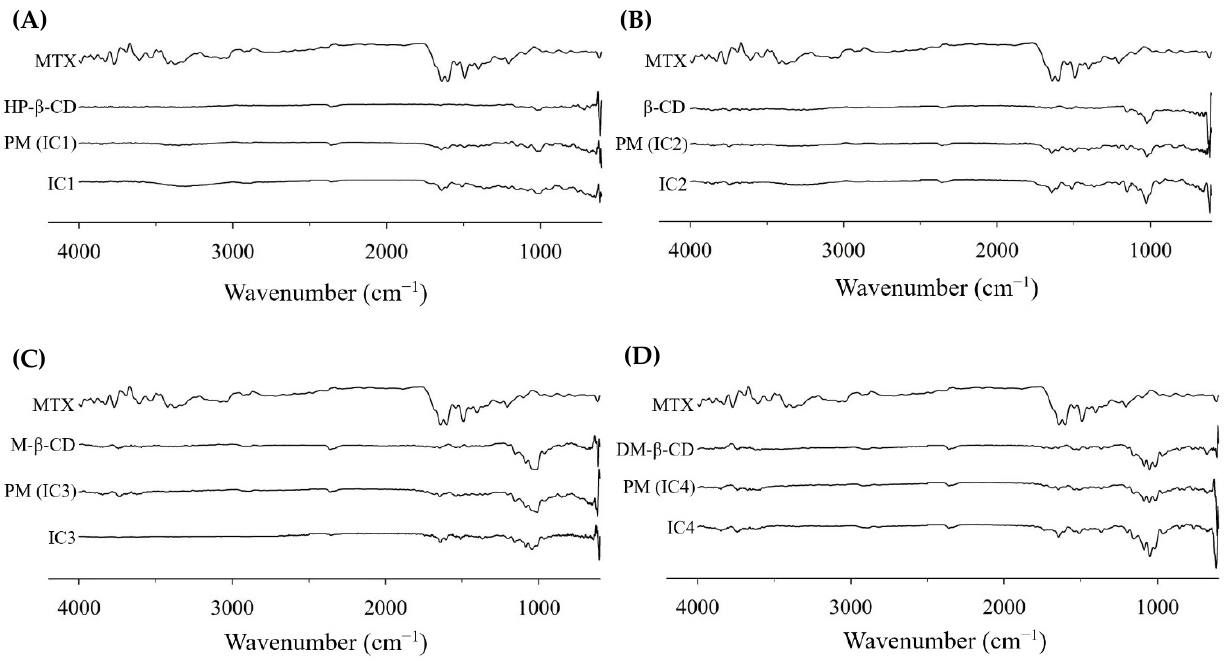
Figure 6. FTIR spectra of the MTX powder, cyclodextrins, physical mixtures, and MTX-CD inclusion complex formulations: ( A ) MTX/HP- β -CD inclusion complex (IC1); ( B ) MTX/ β -CD inclusion complex (IC2); ( C ) MTX/M- β -CD inclusion complex (IC3); and ( D ) MTX/DM- β -CD inclusion complex (IC4).